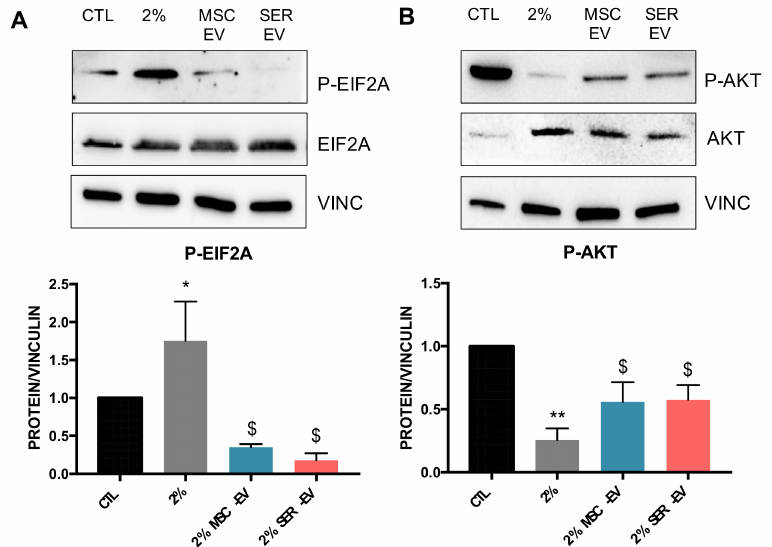
Figure 5. Western blot analysis on HCECs of ER stress related protein phosphorylation. HCECs were exposed to serum starvation for 24 h and further stimulated for 1 h with MSC- or SER-EVs. ( A , B ) Representative images of Western blot on HCECs in normal conditions (CTL), in serum deprivation (2%), and in serum deprivation in the presence of 10 × 10 3 MSC-EV/cell (2% MSC-EV) or in the presence of 10 × 10 3 SER-EV/cell (2% SER-EV). ( A ) Protein levels and the quantification of phospho- EIF2a normalized to total EIF2a and vinculin (VINC). ( B ) The protein levels and the quantification of p-AKT normalized to total Akt and vinculin (VINC) and to CTL. CTL, set as 1, was used as a reference sample for each experiment. The graphs show the average of at least three independent experiments ± SD. One-way ANOVA with Tukey’s multiple comparisons test was performed after the normalization of each experiment to CTL; * p < 0.05 vs. CTL, ** p <0.001 vs. CTL, $ p < 0.05 vs.